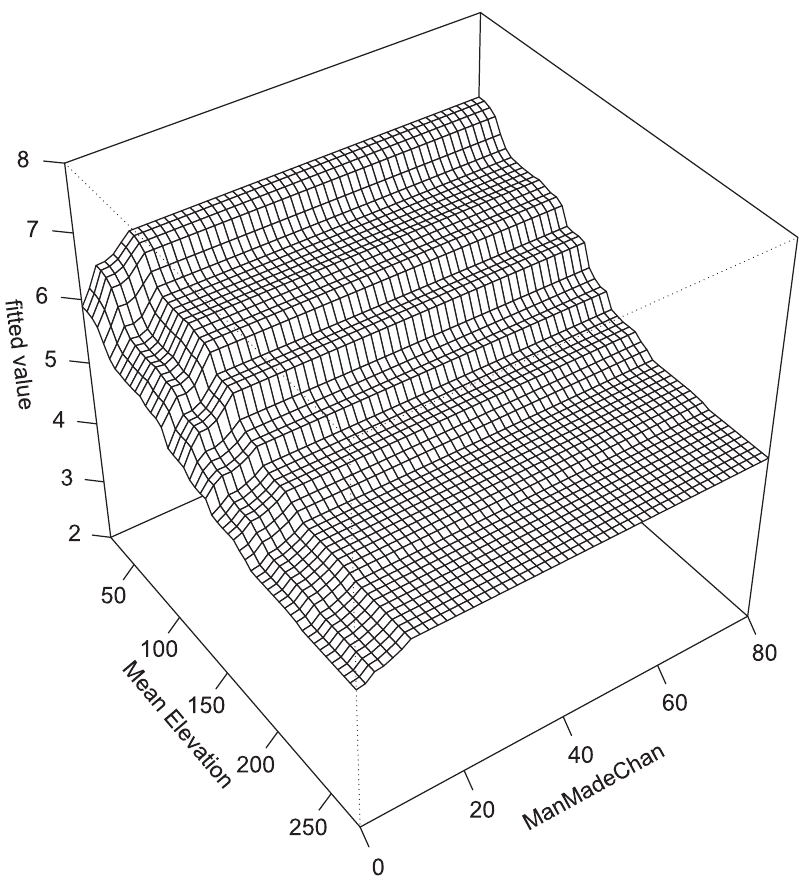
Figure 7. Interaction of manmade streams and mean elevation on RichTOL for Northern Piedmont BRT model. Boosted regression tree partial dependency plot shows the response form of average taxa tolerance (y-axis = fitted function of RichTOL) based on the effect of the interaction of two individual explanatory variables along the response variable (all other variable responses removed). There is a relatively strong interaction acting on RichTOL at low values of mean elevation and high values of percent manmade streams that cause high values of tolerant taxa to occur. This is a common pattern, higher urbanization occurring in the lower elevation valleys.